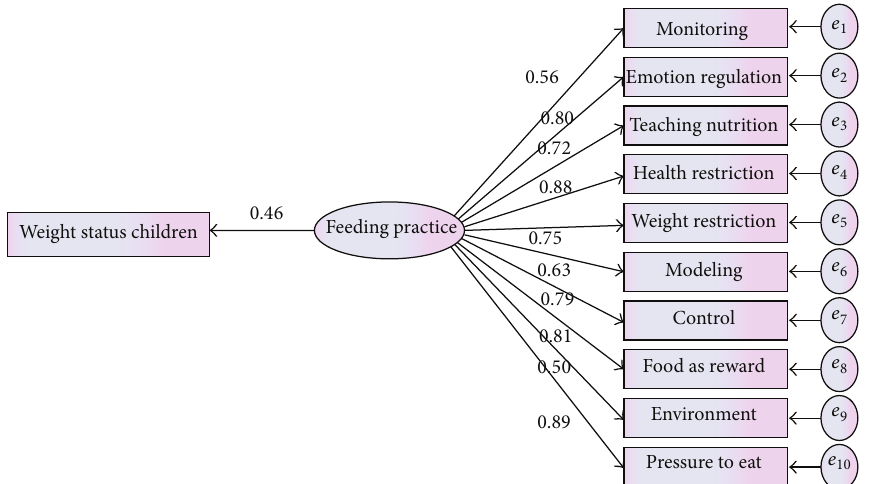
Figure 10: Standardized path coefficients and residual variance in the fourth model.